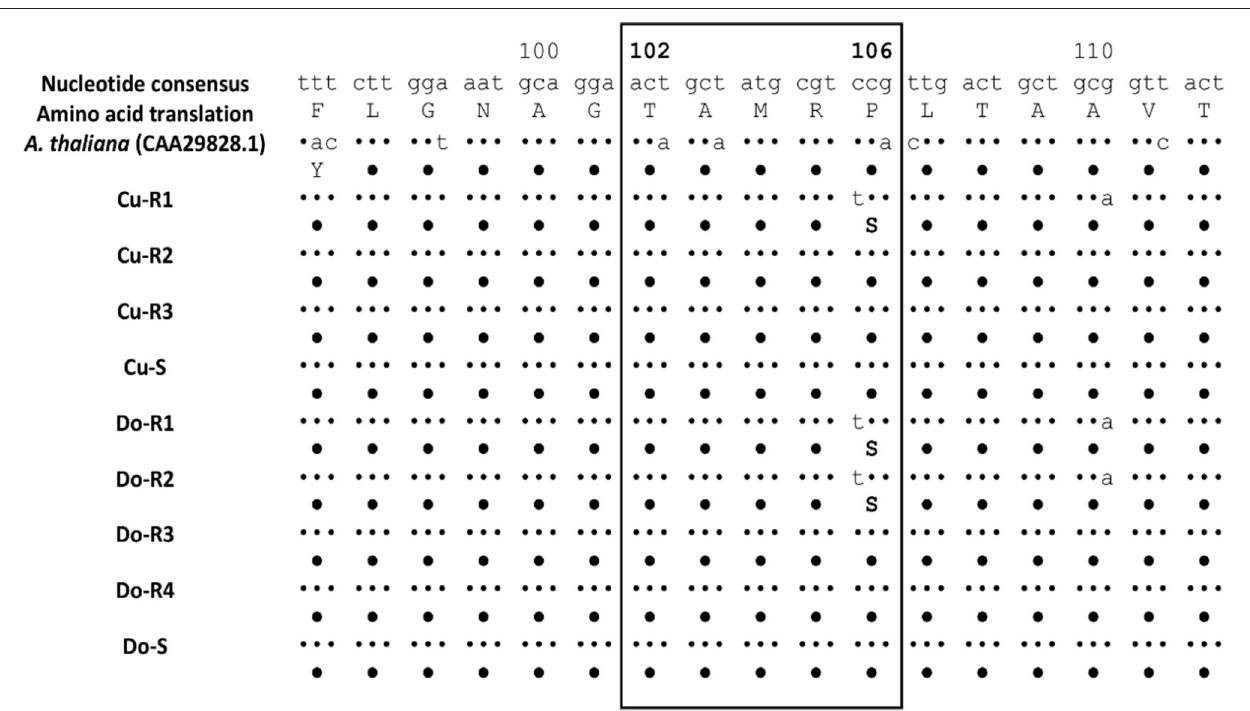
FIGURE 6 | Partial protein sequence alignment of the EPSPS gene of resistant and susceptible P. hysterophorus plants. The box comprising the region of Thr-102 and Pro-106 point mutations associated to confer glyphosate resistance. The points indicate homology between the different sequences.